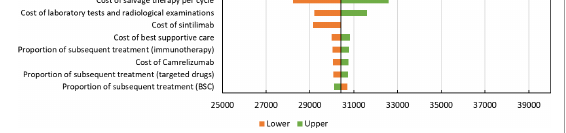
FIGURE 1 Tornado Diagram Showing Results of Deterministic Sensitivity Analysis. DSA, Deterministic Sensitivity Analysis; PD, progressed disease; PFS, progression-free survival; BSC, best-supportive care; QALY: quality-adjusted life years. The vertical black line represents the primary result of $30409.44 per